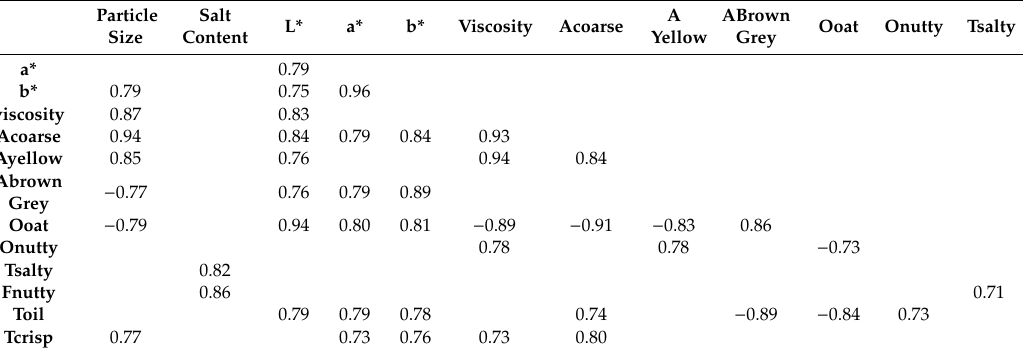
Table 7. Pearson correlation coefficients ≥ 0.7 are given in the table.